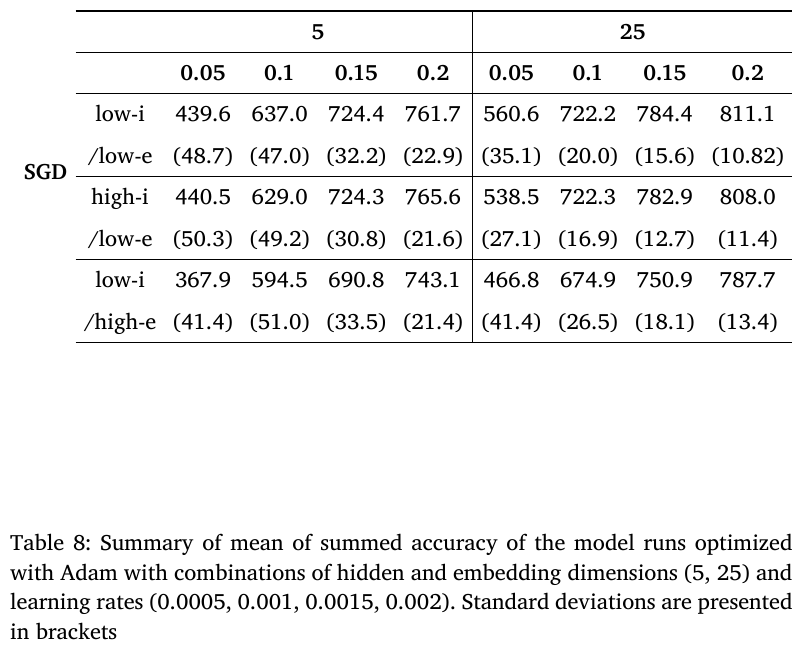
Table 7: Summary of mean of summed accuracy of the model runs optimized with SGD with combinations of hidden and embedding dimensions (5, 25) and learning rates (0.05, 0.1, 0.15, 0.2). Standard deviations are presented in brackets